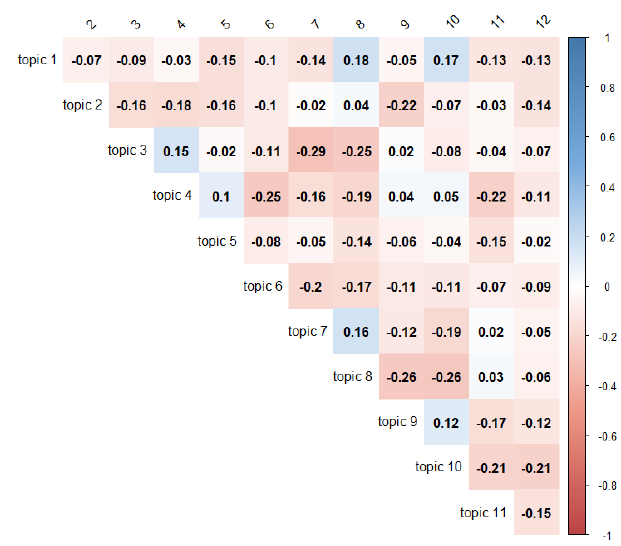
Figure 6. Correlation topics matrix.